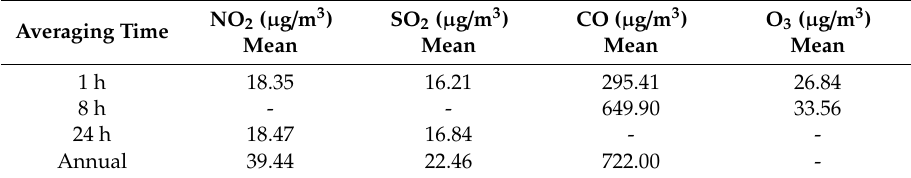
Table 3. Ambient concentrations of NO 2 , SO 2, CO, and O